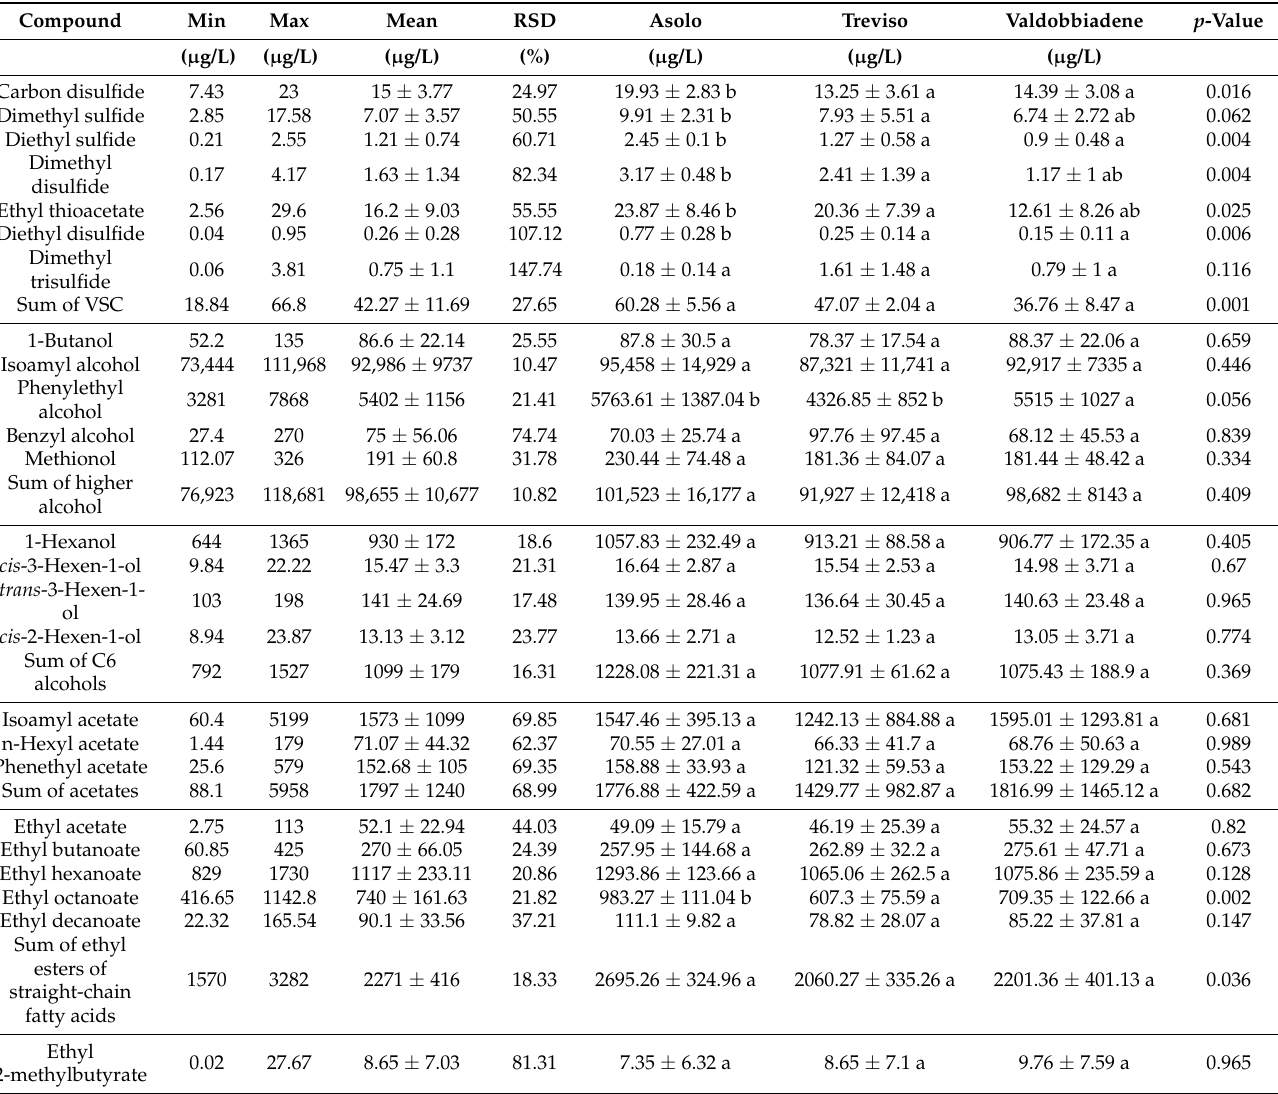
Table 3. Volatile compounds’ minimum concentration (min), maximum concentration (max), and mean concentration of all samples, and relative standard deviation (RSD (%)) in wine samples. Mean value for each production is with significance among the three